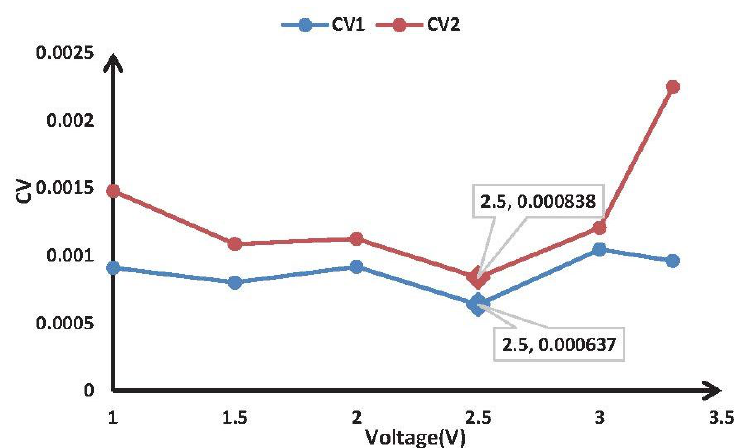
Figure 11. Relationship between the drives and the CV values.